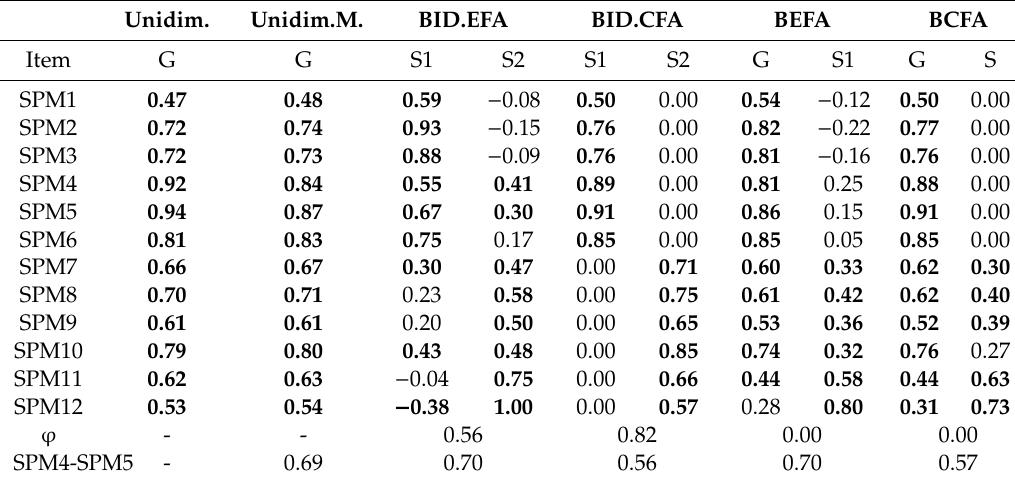
Table 1. Standardized factor loadings for all model tested.